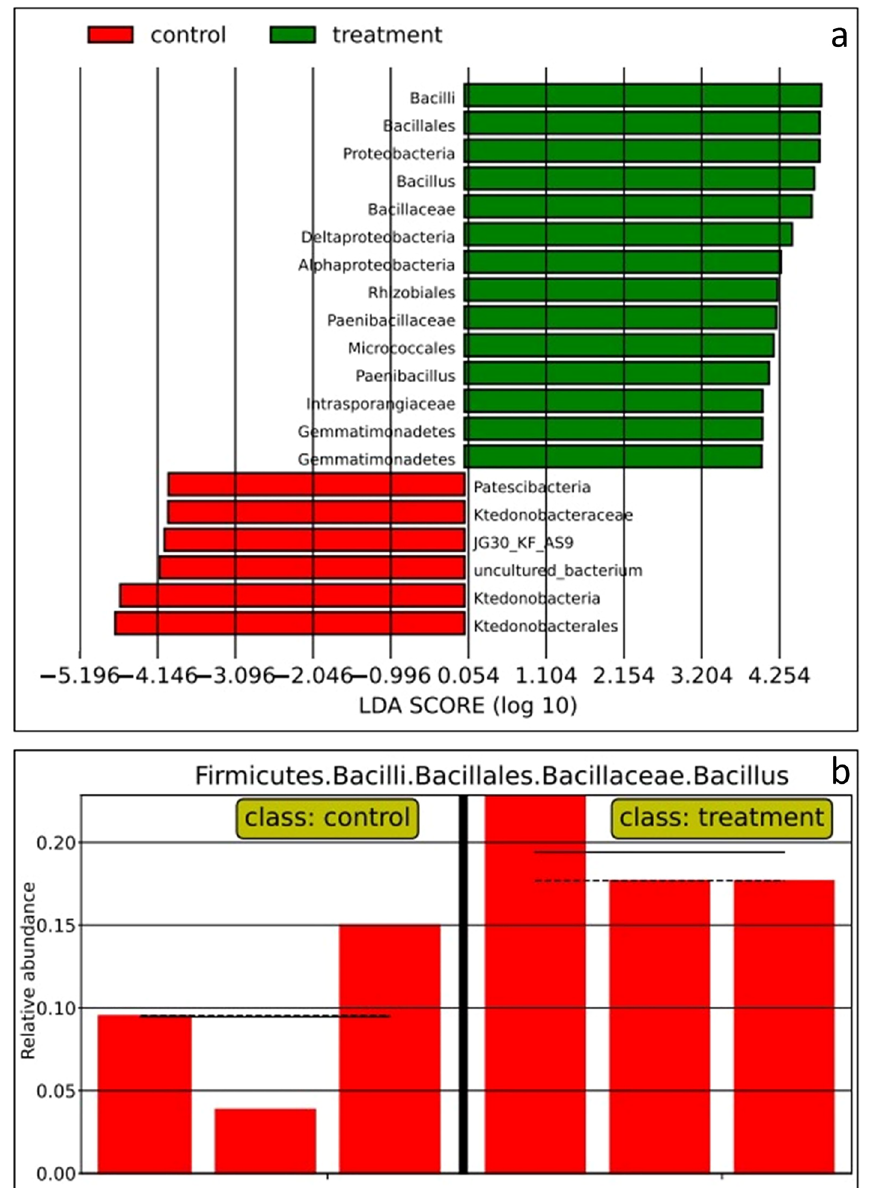
Figure 4. ( a ) Histogram of LDA score of microorganism biomarker computed by LEfSe comparing soil community with and without biochar amendment. ( b ) Relative abundance of Bacillus in biochar soil amendment community (right) and that of Bacillus in non-biochar amendment community